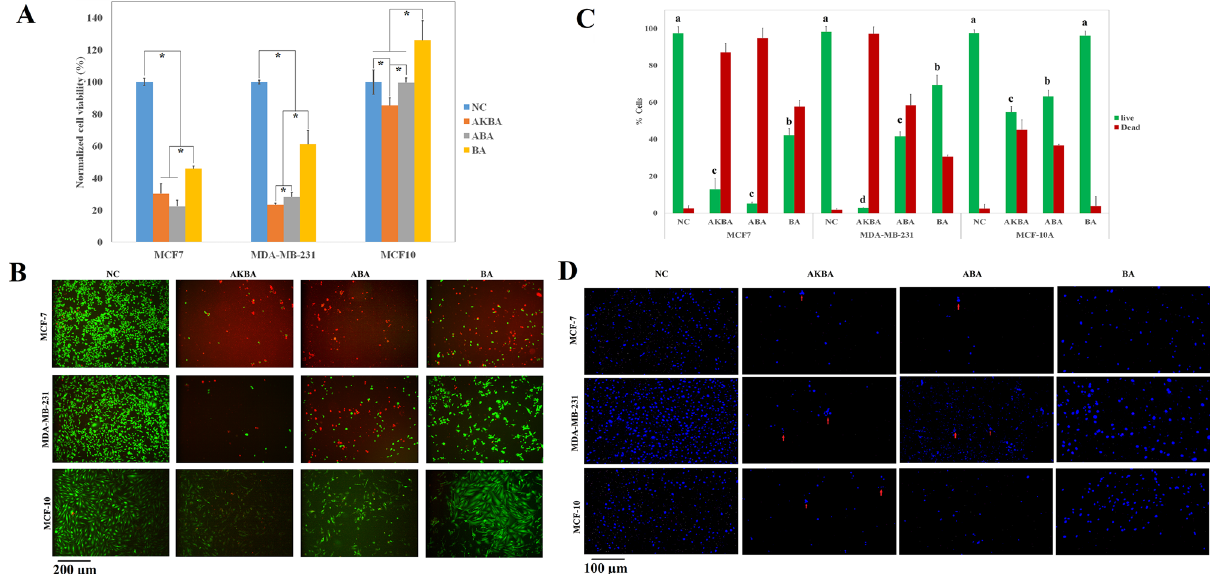
Figure 1. ( A ) the normalized viability of MCF-7, MDA-MB-231, and MCF-10A cells obtained by the MTT assay following 24 h treatment with AKBA, ABA, and BA in comparison with the negative control (NC). * indicated a significant difference (P < 0.05) (N value = 3). ( B ) Live and dead assay of MCF-7, MDA-MB-231, and MCF-10A after 24 h of treatment with AKBA, ABA, and BA in comparison with the negative control (NC). Green and Red are representing live and dead cells, respectively. ( C ) Quantitative analysis of live and dead staining of MCF-7, MDA-MB-231, and MCF-10A after 24 h of treatment with AKBA, ABA, and BA in comparison with the negative control (NC). a, b, c, and d indicate significant levels for the number of live cells (P < 0.05) (N value = 3). D. DAPI staining of MCF-7, MDA-MB-231, and MCF-10A after 24 h treatment with AKBA, ABA, and BA in comparison with the negative control (NC). Arrows represent apoptotic